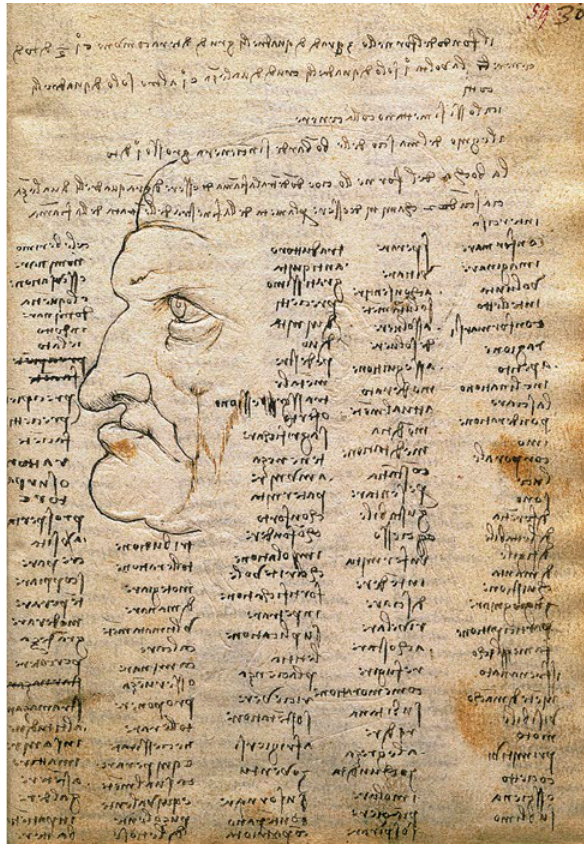
Figure 49. Trying to learn Latin, with a